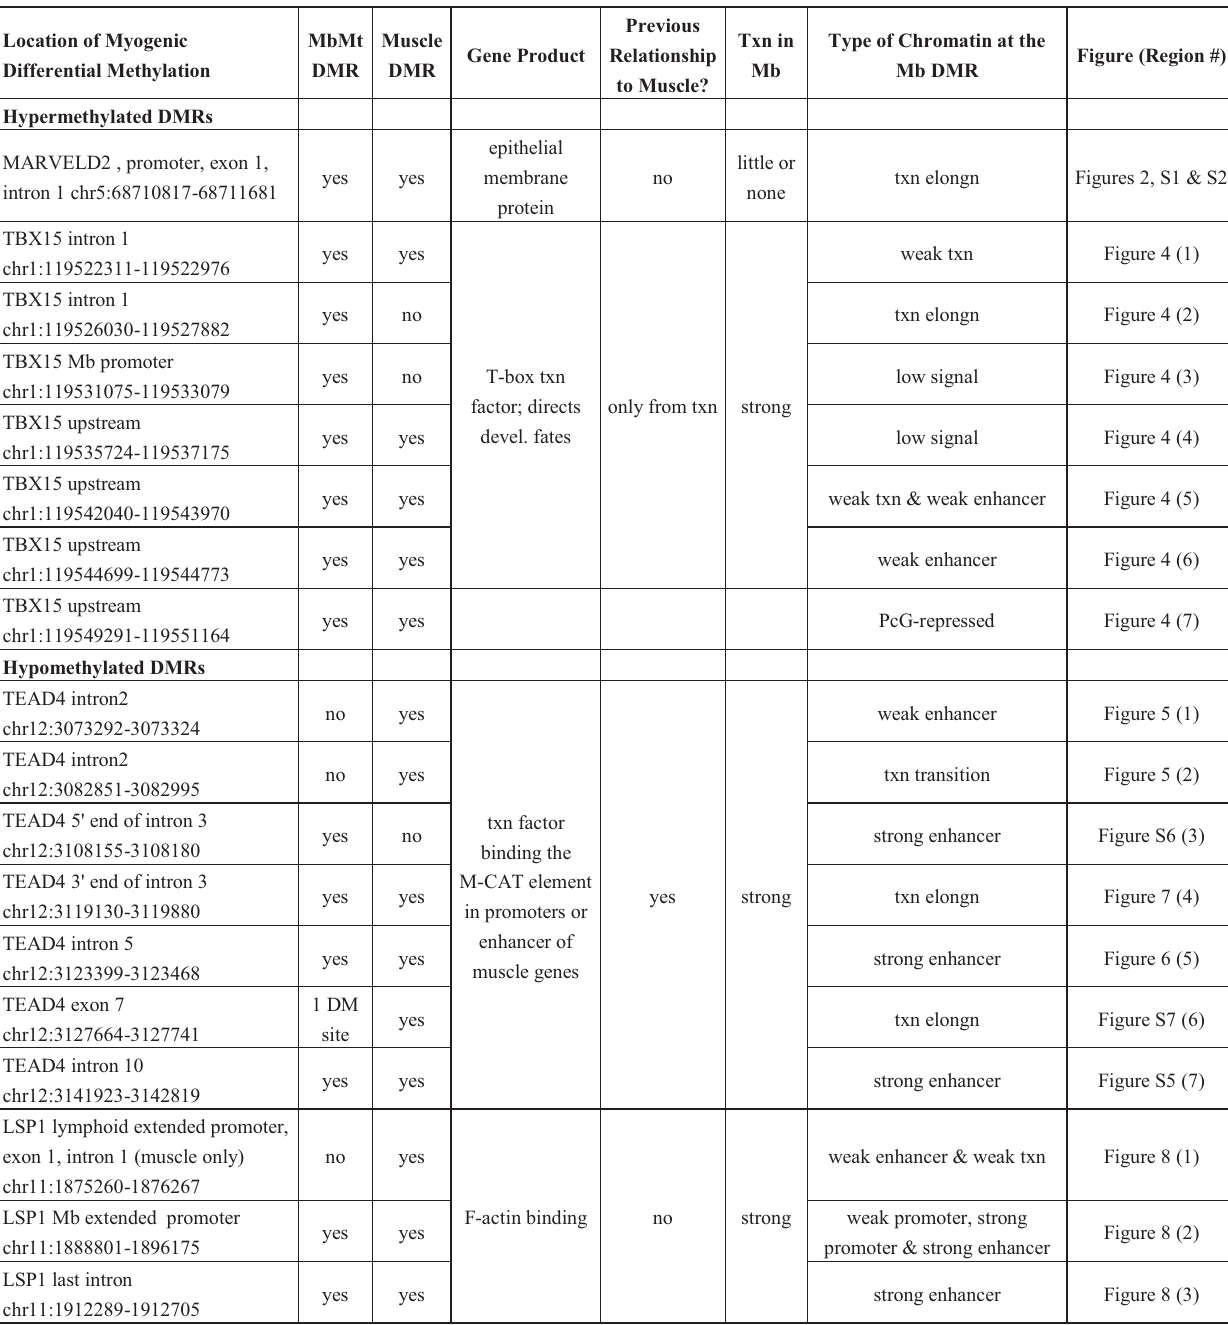
Table 1. Associations between myogenic differentially methylated regions (DMRs) and overlapping chromatin state for four genes a